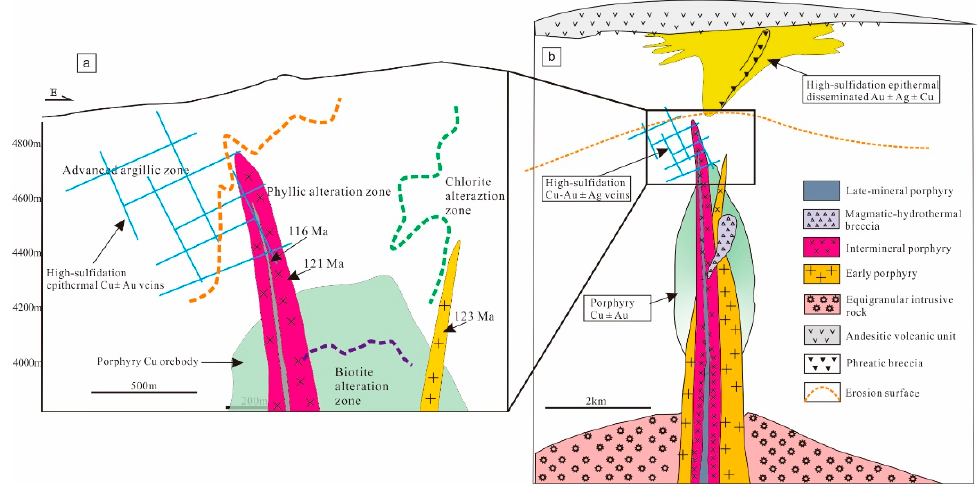
Figure 10. ( a ) Simplified geology map of the A-B sections in Tiegelongnan [31]. ( b ) Anatomy of a condensed porphyry Cu system showing the spatial interrelationships of porphyry Cu orebody, high-sulfidation epithermal Cu ± Au orebody, and late-mineralization andesitic volcanic rocks [31].